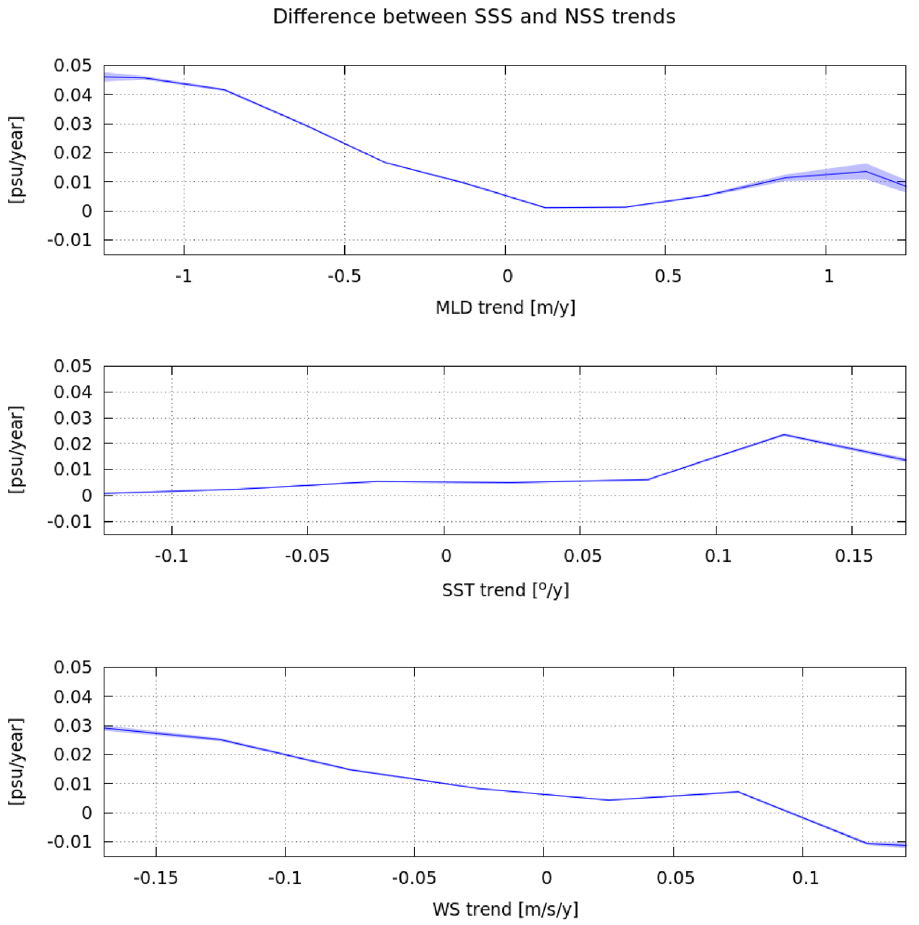
Figure 4. Mean difference between SSS and NSS trends as function of the following trends: mixed layer depth (top panel), sea surface temperature (middle panel), and wind speed (bottom panel). The region considered comprises tropics and middle latitudes (i.e., between 40 regions that may be affected by sea-ice